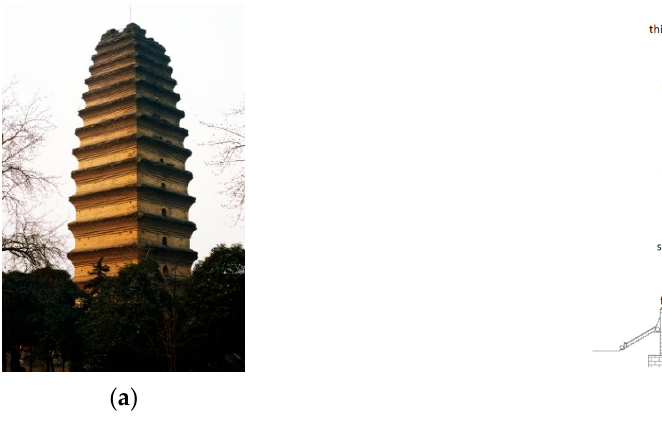
Figure 1. The extant Small Wild Goose Pagoda. ( a ) Live-action. ( b ) Section drawing.